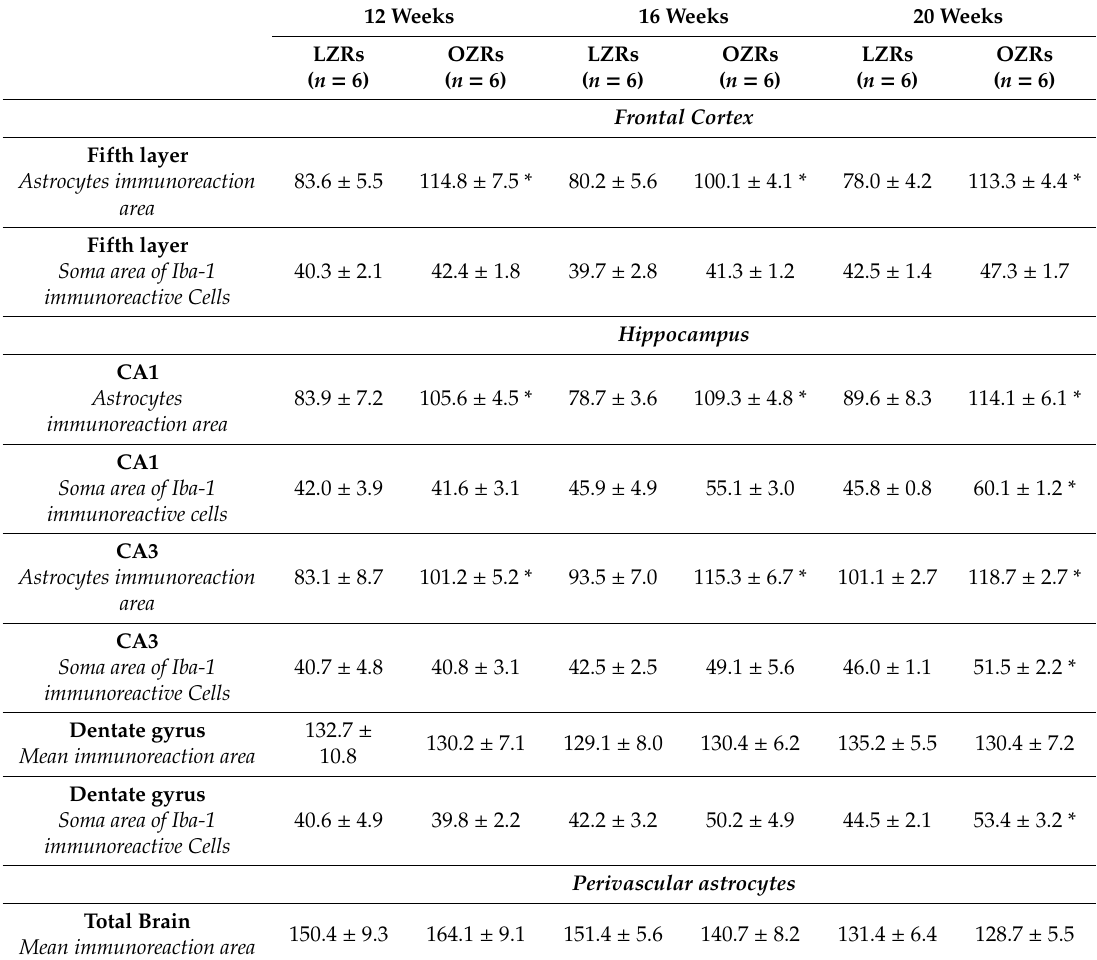
Table 3. Mean immunoreaction area of GFAP and Iba-1 in the frontal cortex and hippocampus of lean and obese Zucker rats at the di ff erent